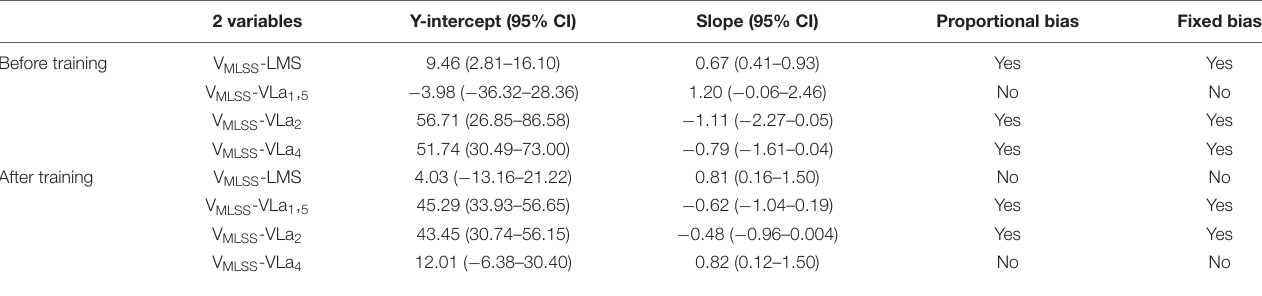
TABLE 6 | Ordinary least products regression results for the V MLSS vs. the LMS/VLa 1 . 5 , 2 , 4 before and after 8 weeks of